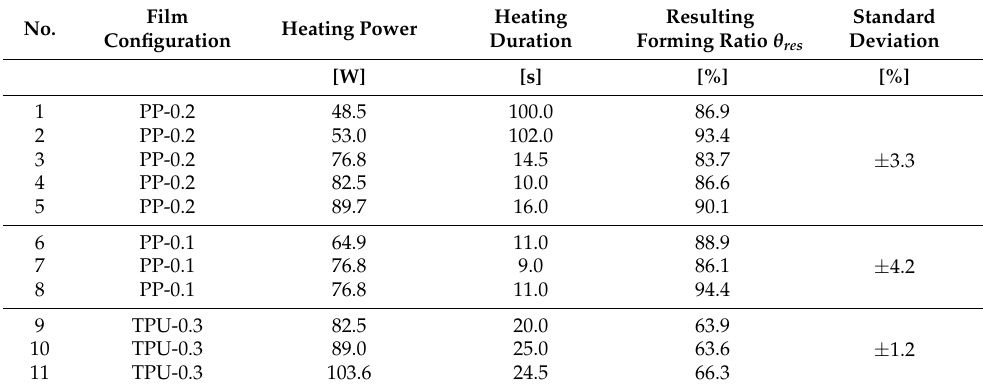
Table 2. Resulting forming ratio for different film configurations and heating